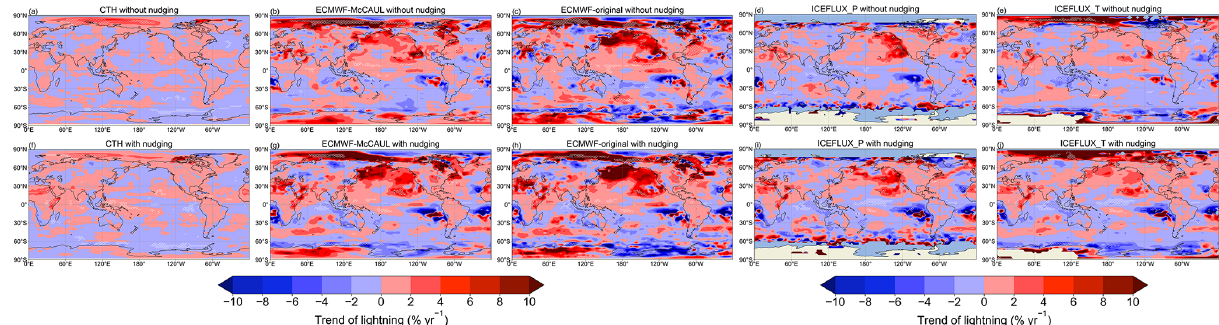
Figure 13. Changes in the lightning flash rate (%yr − 1 ) during 2001–2020 on the two-dimensional map. Changes at every point were calculated from the function of the approximating curve for the 2001–2020 time series data at each grid cell. Panels (a) – (e) show results without nudging; panels (f) – (j) show results with nudging. There are some missing values in the case of the ICEFLUX scheme because the upward cloud ice flux used is diagnosed as zero by the CHASER model, typically within the high-latitude